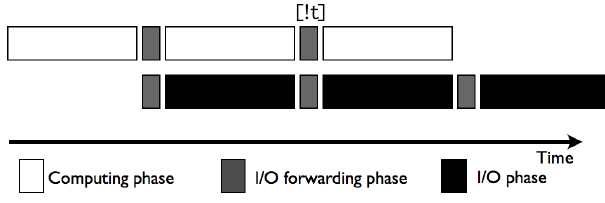
Fig. 4. Overlapping I/O with computing through I/O